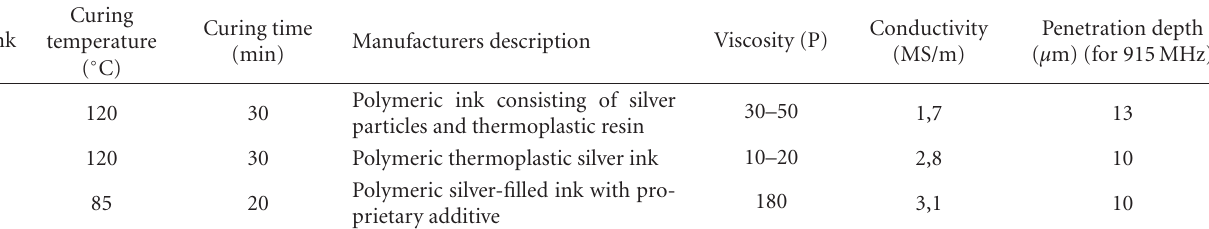
Table 3: The characteristics of the silver inks.